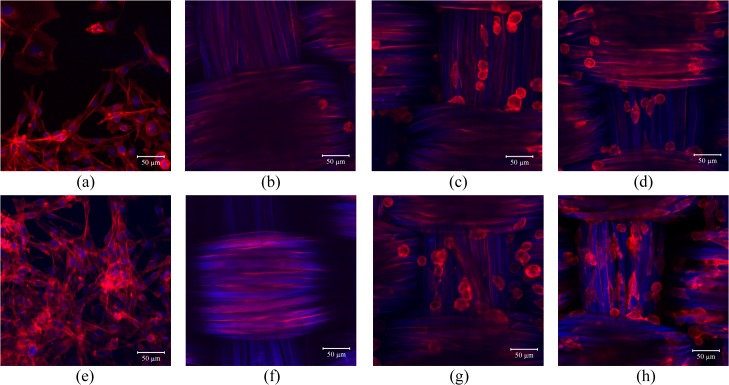
Confocal images of the PIECs on TCPs, SF fabrics and self-assembled (ALG/RSF)n SF fabrics with the cell nuclei stained with DAPI (Blue) and F-actin stained with phalloidin-TRITC (Red).(a) TCPs cultured for 1 day, (b) SF fabric cultured for 1 day, (c) self-assembled (ALG/RSF)1.5 SF fabric cultured for 1 day, (d) self-assembled (ALG/RSF)9.5 SF fabric cultured for 1 day, (e) TCPs cultured for 3 days, (f) SF fabric cultured for 3 days, (g) self-assembled (ALG/RSF)1.5 SF fabric cultured for 3 days, and (h) self-assembled (ALG/RSF)9.5 SF fabric cultured for 3 days. The scale bar is 50 μm.